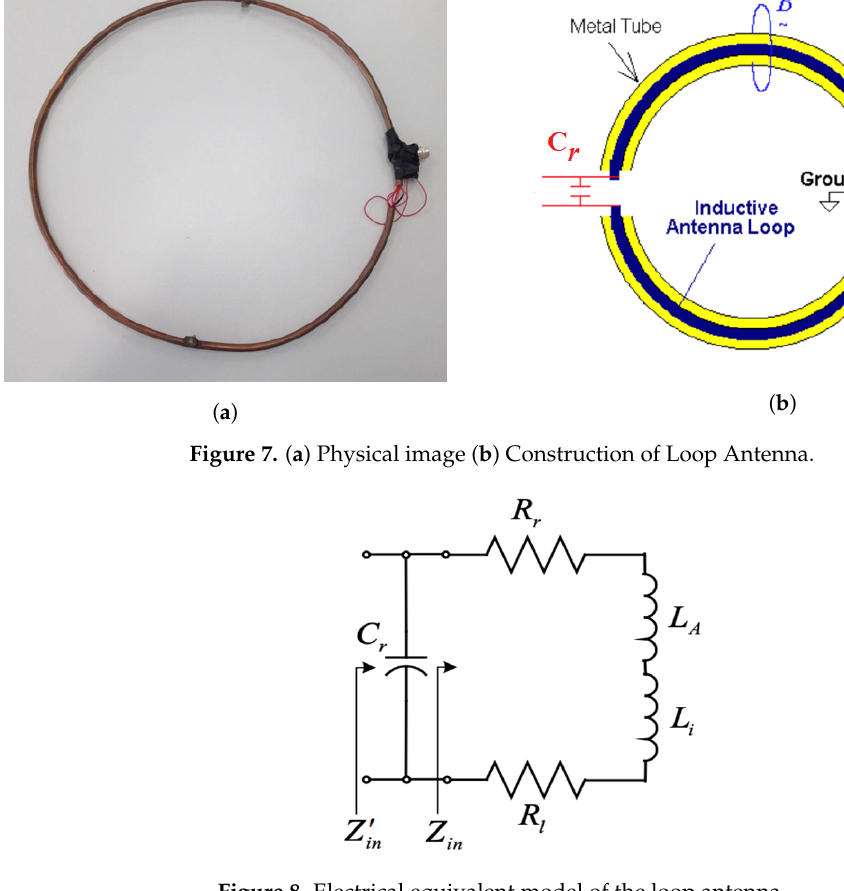
Figure 8. Electrical equivalent model of the loop